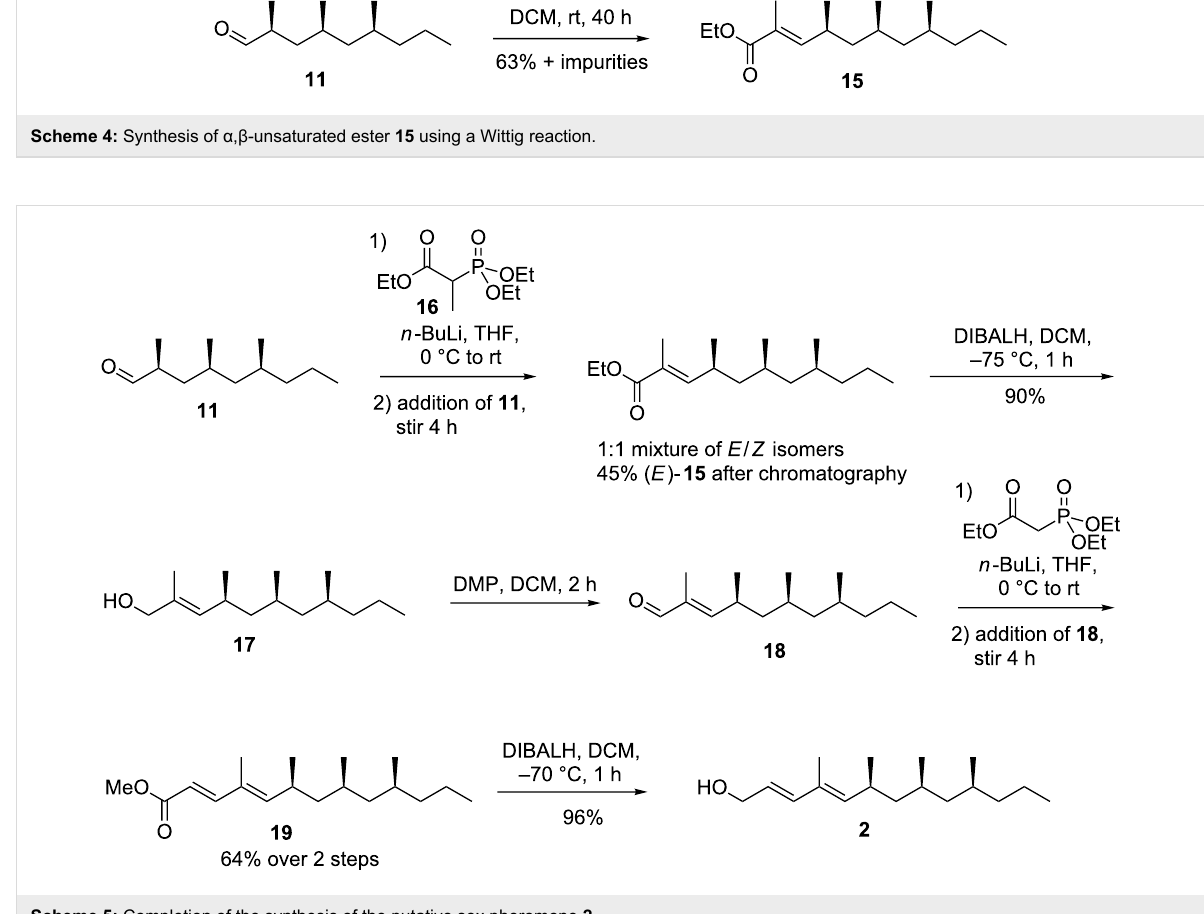
Scheme 5: Completion of the synthesis of the putative sex pheromone 2